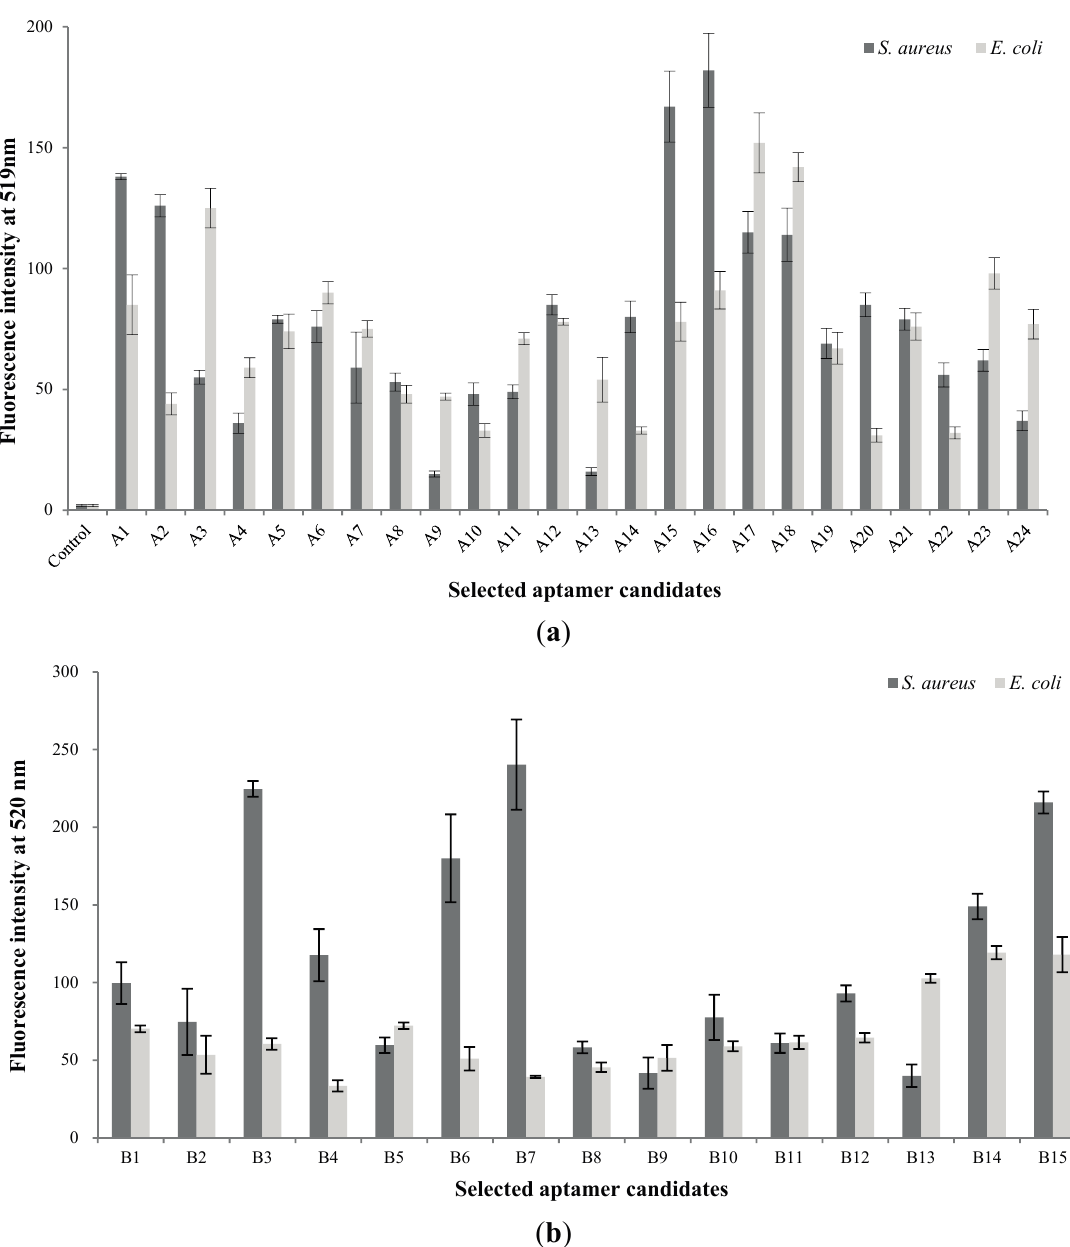
Figure 2. ( a ) Validation of the binding specificity of selected aptamer candidates by using the basic whole-cell SELEX procedure; ( b ) Validation of binding specificity of selected aptamer candidates by using the modified whole-cell SELEX